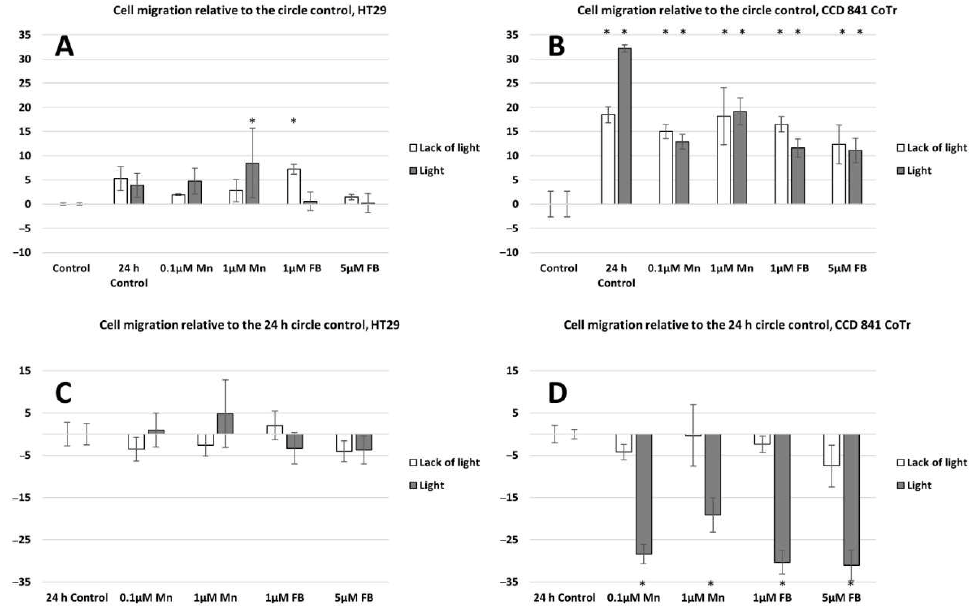
Figure 7. Percent of cell migration relative to the circle control: ( A )—HT29 and ( B )—CCD 841 CoTr; cell migration relative to the 24 h circle control: ( C )—HT29 and ( D )—841 CoTr. A negative percent means inhibiting the migration. Columns and bars show the mean ± standard deviation (n = 3). Statistical significance was analysed at p < 0.05. * Statistical significance in comparison to appropriate control at p <